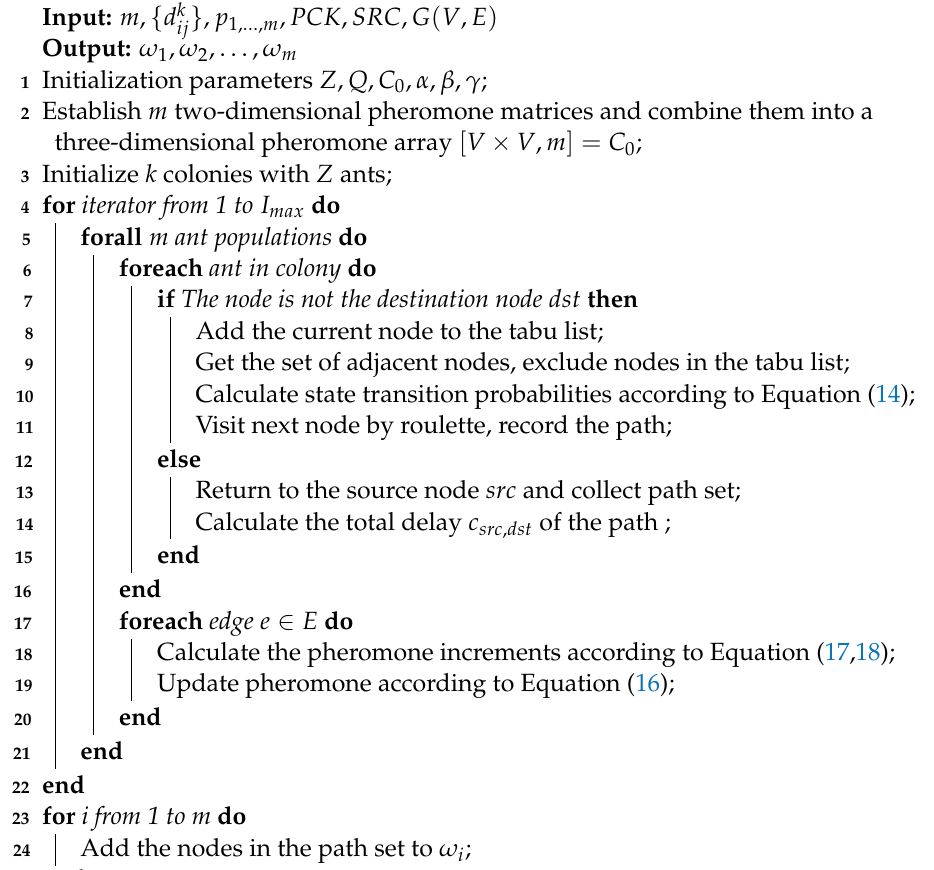
Algorithm 2: AACO algorithm for non-TT flow route